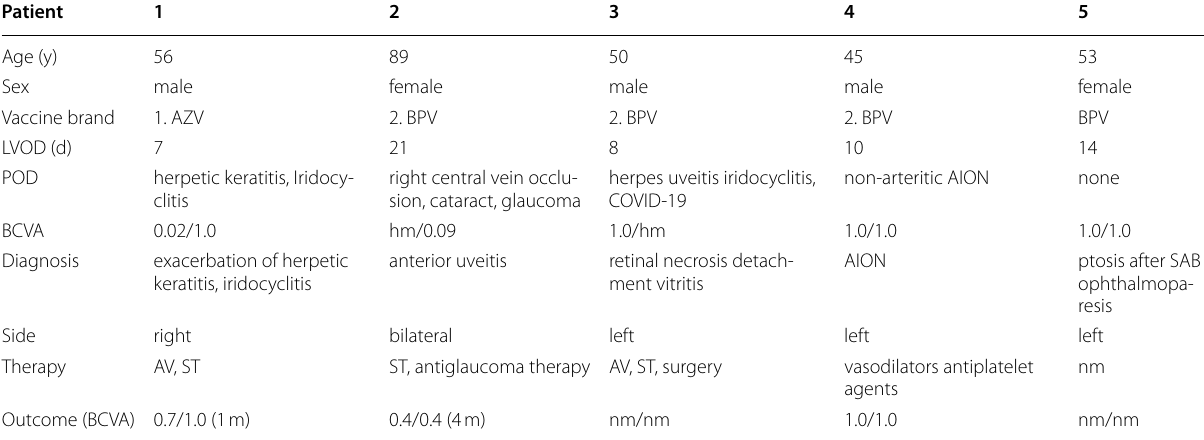
Table 1 Clinical data of the five patients presented in the report Patient